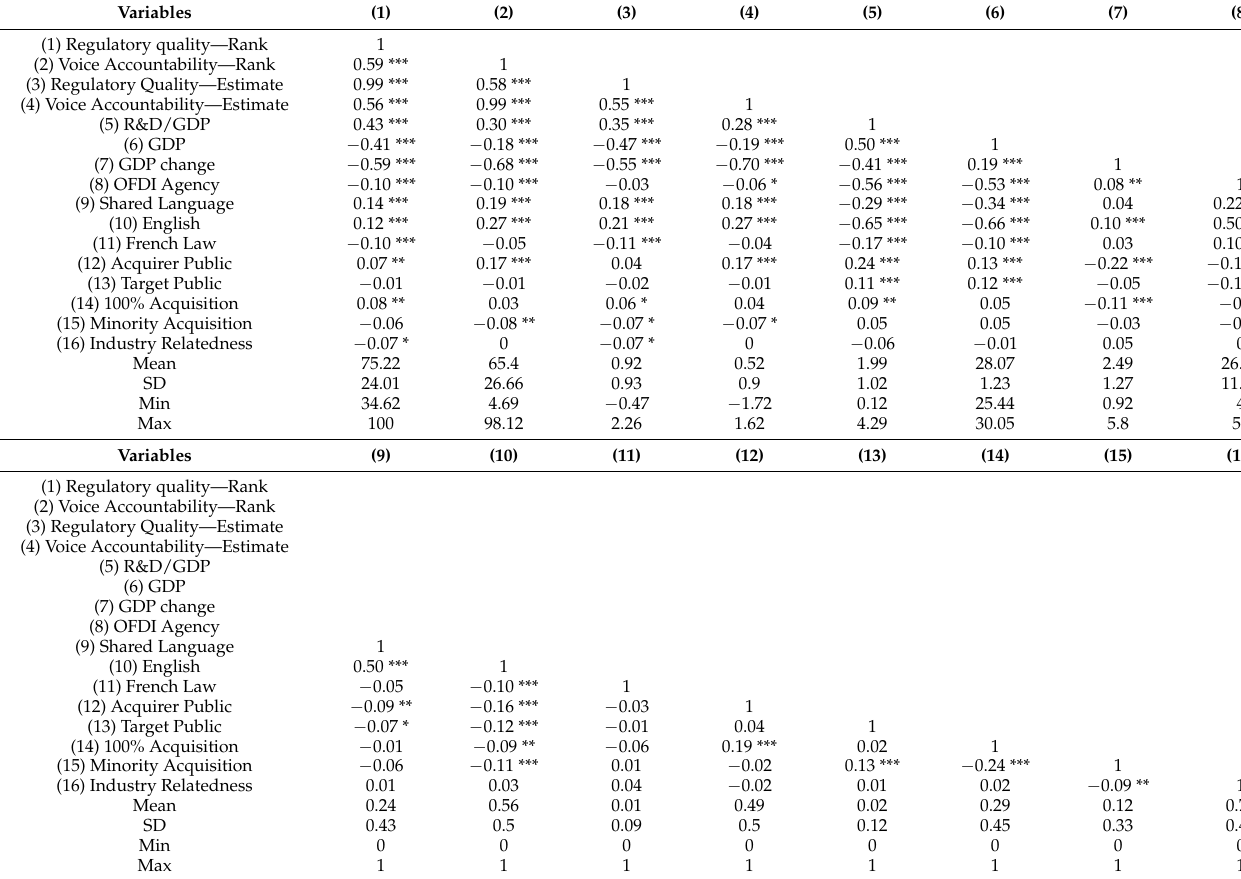
Table A4. Correlation table and summary statistics.